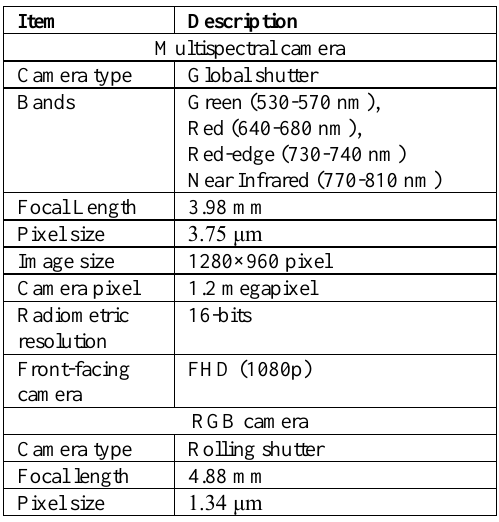
Table 1 . Parrot Sequoia specifications